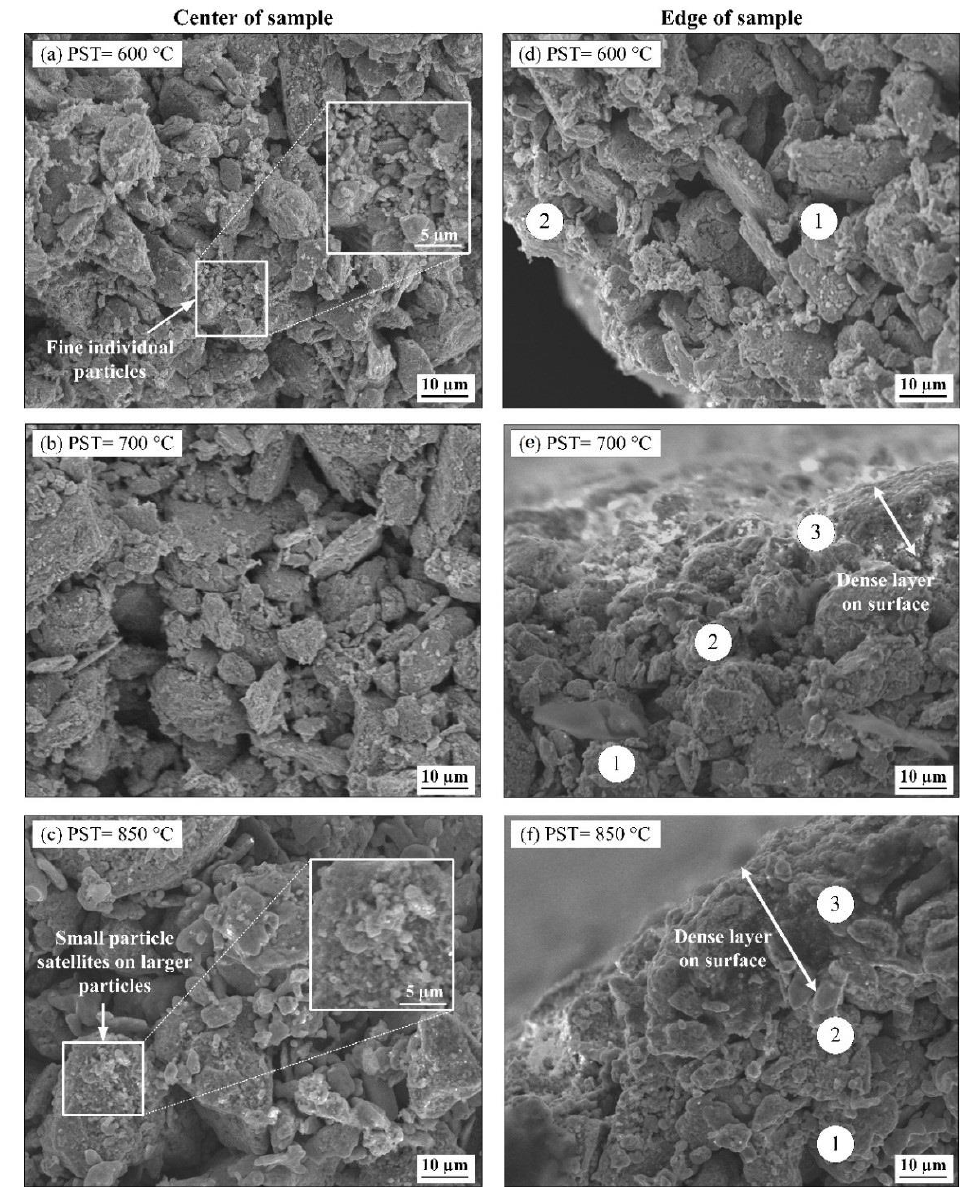
Figure 7. SEM observations of the debound specimens ( a – c ) at the center and ( d – f ) at the specimens’ edge.